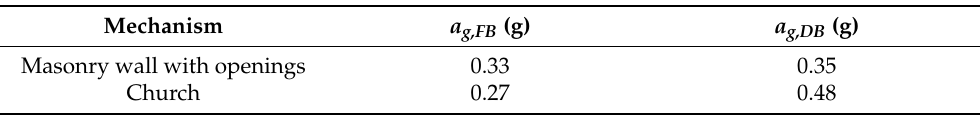
Table 2. Comparison of peak ground accelerations (PGAs) for which the Italian code safety check is violated using both the force-based and displacement-based